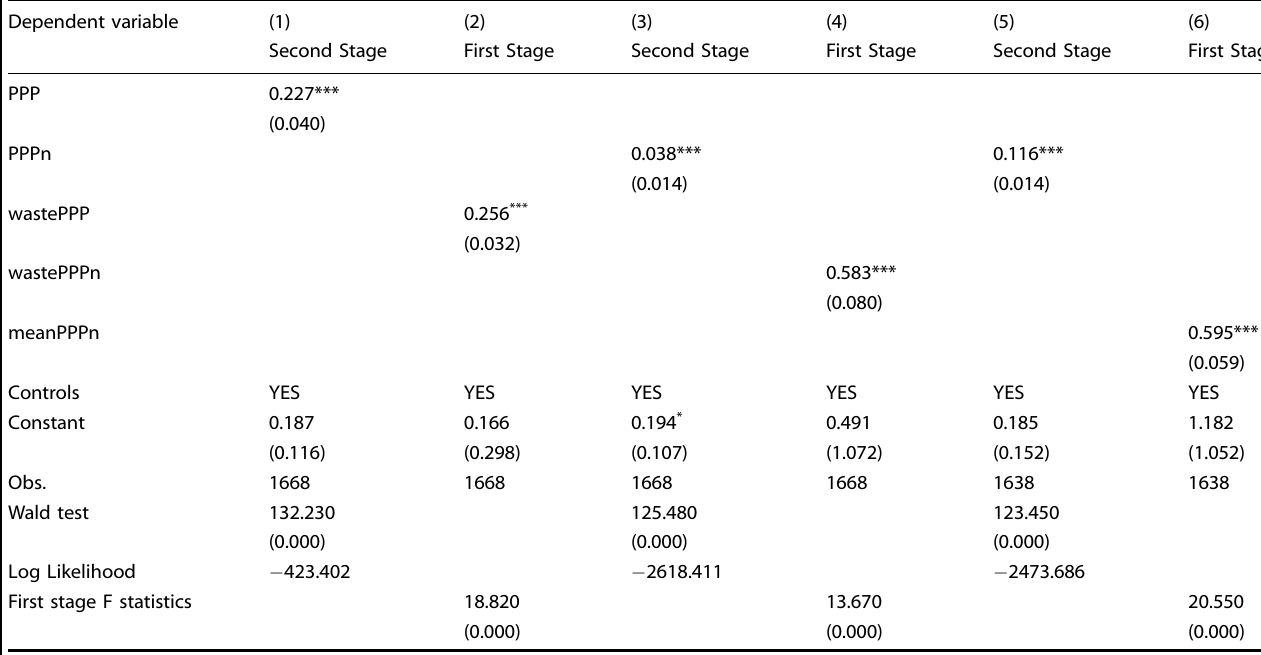
Table 3. Estimation results of the instrument variable regression model using 2SLS estimations method.